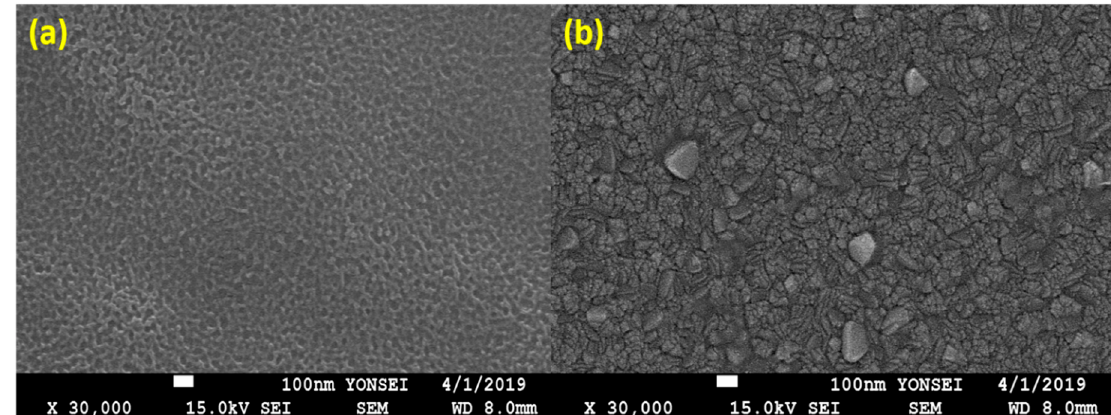
Figure 3. FE-SEM images of ( a ) N,N'-methylenebisacrylamide (MBA)–PAA/ITO and ( b ) CuO–MBA– PAA/ITO electrode.